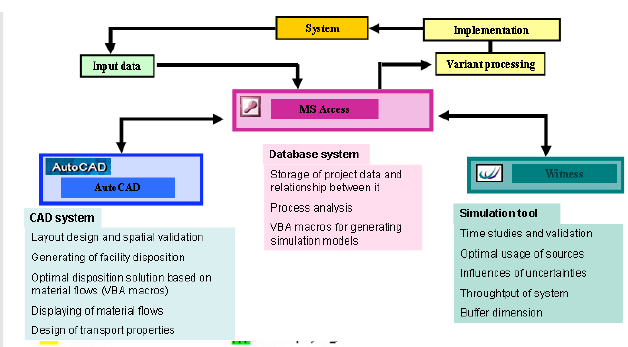
Fig. 4. Most common functionalities of each integrated soft- ware